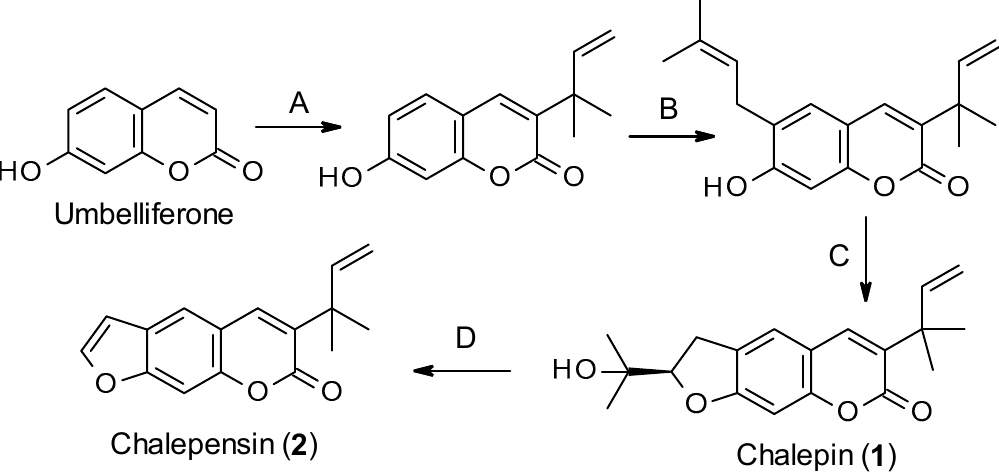
Figure 2. Putative biosynthetic route for the formation of chalepin ( 1 ) and chalepensin ( 2 ).